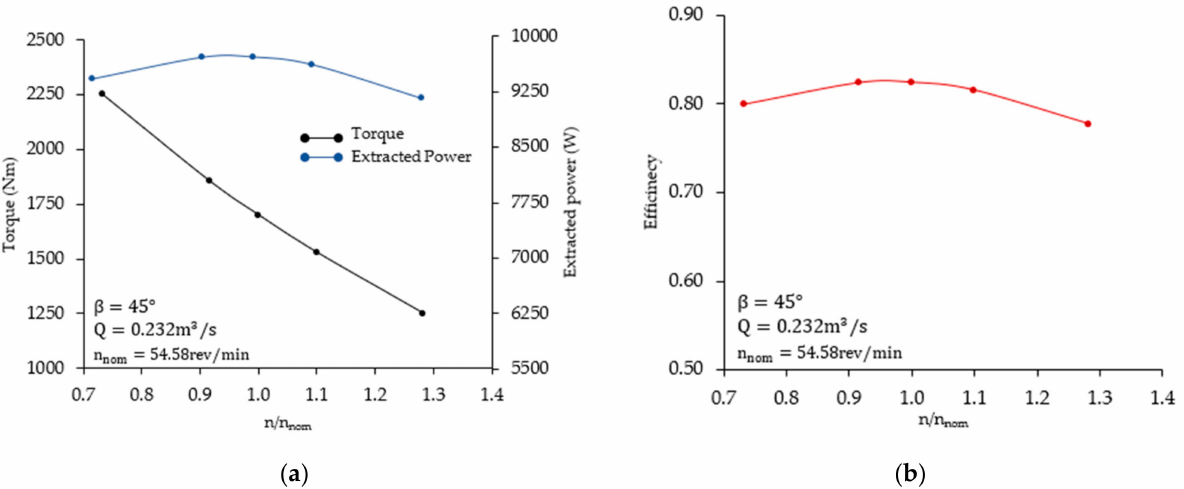
Figure 9. AST performance curves for 45 0 inclination ( a ) Torque and Extracted power variation, ( b ) Efficiency